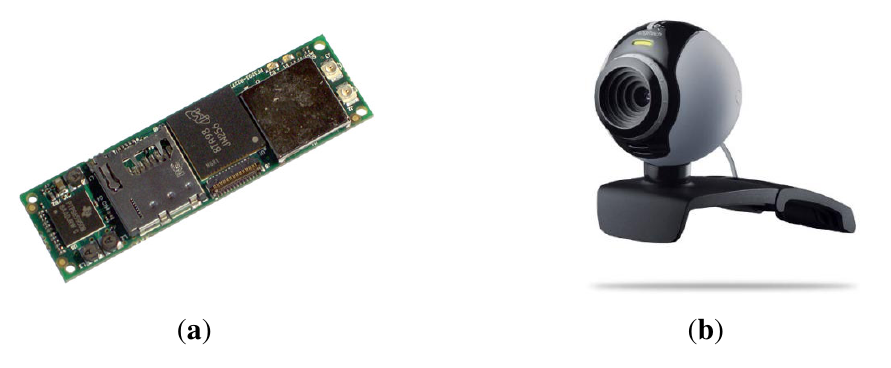
Table 1. Processing times for different image sizes by a camera